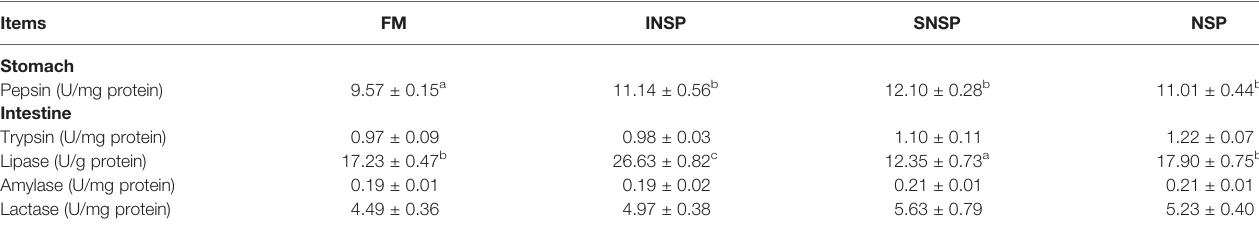
TABLE 3 | Digestive enzyme activities in GIFT tilapias fed diets with different types of non-starch polysaccharides.